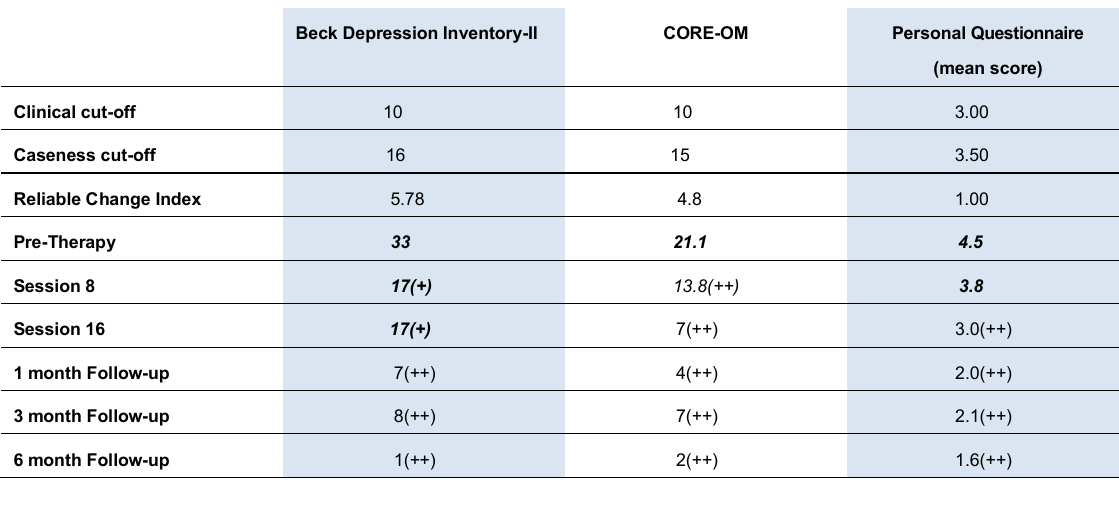
Table 1: Denise’s Quantitative Outcome Data